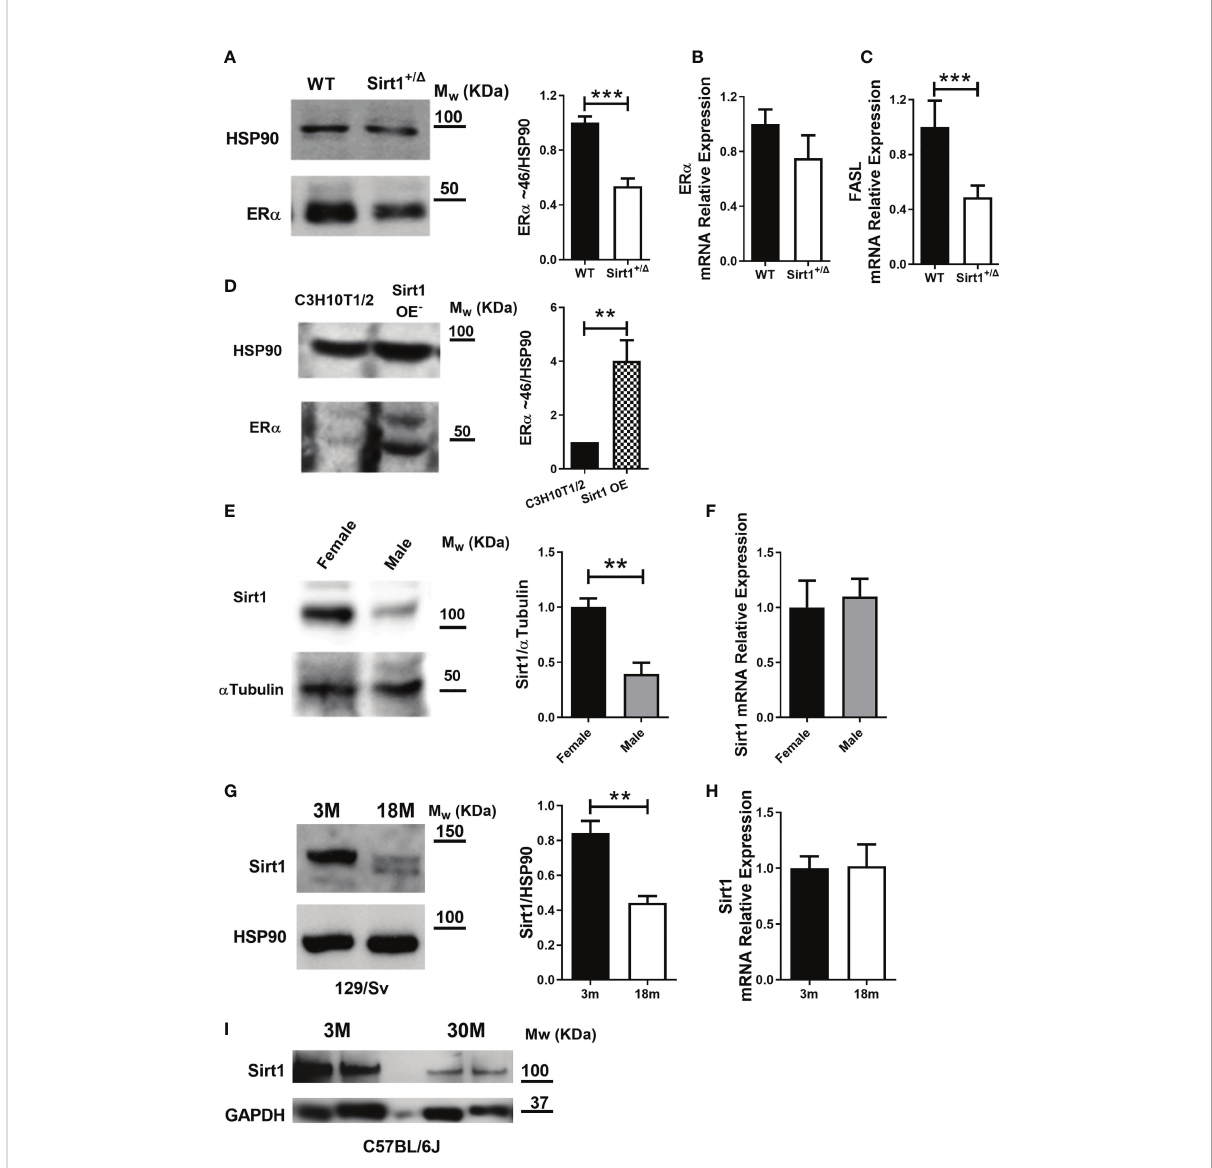
FIGURE 6 SIRT1 upregulates ER a in bone, is lower in males and declines with aging in female mice. (A) Immunoblot of ER a in whole vertebrae in 5- month-old Sirt1 +/ D and WT female mice. A representative image (left) and densitometry (right) with HSP90 as control. (B) ER a mRNA and (C) FASL mRNA relative expression in whole vertebrae in 5-month-old Sirt1 +/ D and WT female mice with b Actin and GAPDH as controls. (D) Immunoblot of ER a in Sirt1 over-expressing and control C3HT101/2 cells. A representative image (left) and densitometry (right) with HSP90 as control (n = 3 independent experiments). (E) SIRT1 protein and (F) Sirt1 mRNA in whole vertebrae in 5-month-old WT female and male mice. A representative image (left) and densitometry (right) with a -tubulin and GAPDH as controls, respectively. (G) SIRT1 protein level in whole vertebrae in 3- and 18-month-old WT 129/Sv female mice (n = 3 mice/group). A representative image (left) and densitometry (right) with HSP90 as control. (H) Sirt1 mRNA relative expression in whole vertebrae in 3- and 18-month-old WT 129/Sv female mice (n = 3 mice/group) with b Actin , Polr2A and GAPDH as controls. (I) SIRT1 protein level in whole femur in 3- and 30-month-old C57BL/6J WT female mice (n = 3 mice/ group) with GAPDH as control. Results are mean ± SEM analyzed by unpaired Student ’ s t -test. ** P < 0.01 versus C3H10T1/2 cells (D) ; ** P < 0.01 versus WT female mice (E) ; ** P < 0.01 versus 3-months-old WT 129/Sv female mice; (G) *** P < 0.001 versus WT female mice (A, C) (n = 6-9 mice/group, unless otherwise speci fi